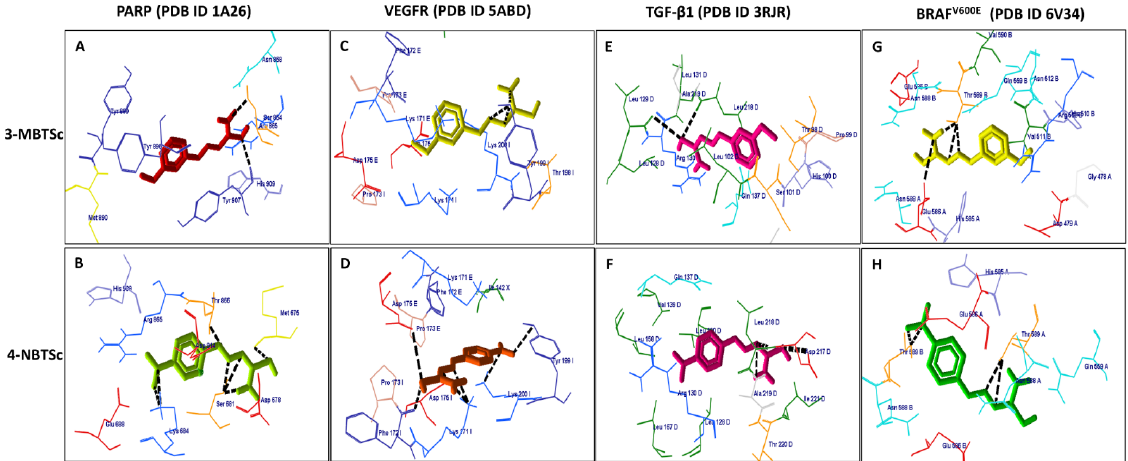
Figure 1. Interaction of 3-MBTSc and 4-NBTSc with ( A , B ) PARP: Poly (ADP-ribose) polymerase; ( C , D ) VEGFR-1: Vascular endothelial growth factor receptor-1 ( E , F ) TGF- β 1: pro- transforming growth factor beta 1 ( G , H ) BRAF V600E . ( A ) 3-MBTSc (Red) formed one hydrogen bonding with Tyrosine 907 (Midnight blue) and Serine 854 (Royal). ( B ) 4-NBTSc (green) in- teracted with four amino acids, Serine 681(Honey), Lysine 684 (light blue), Threonine 866 (Royal) and Methionine 675 (Yellow). ( C ) 3-MBTSc (Yellow) made three hydrogen bonds with Tyrosine 199 (Midnight blue) amino acid. ( D ) 4-NBTSc (Bronze) has interacted with Proline 173 (Cantaloupe), Aspartate 175 (Red) and Tyrosine 199 (Midnight blue) with one hydrogen boding and lysine171 and Lysine 200 (light blue) in three hydrogen bonds. ( E ) 3-MBTSc (Pink) formed two hydrogen bonds with Leucine amino acid (Leu 218 and Leu 129) (Green). ( F ) Amino acid- Alanine 219 (White), Leucine 218(Green), Aspartate 217 (Red) and Serine 228 are involved in one hydrogen bond with the synthesized compound 4- NBTSc (Carmine). ( G ) 3-MBTSc (Yellow) formed one hydrogen bond with Glutamate 586 (Red) and three hydrogen bonds with Threonine 589 (Royal). ( H ) The test compound 4-NBTSc (Green) formed four hydrogen bonds with Threonine 589 (Royal) amino acid.